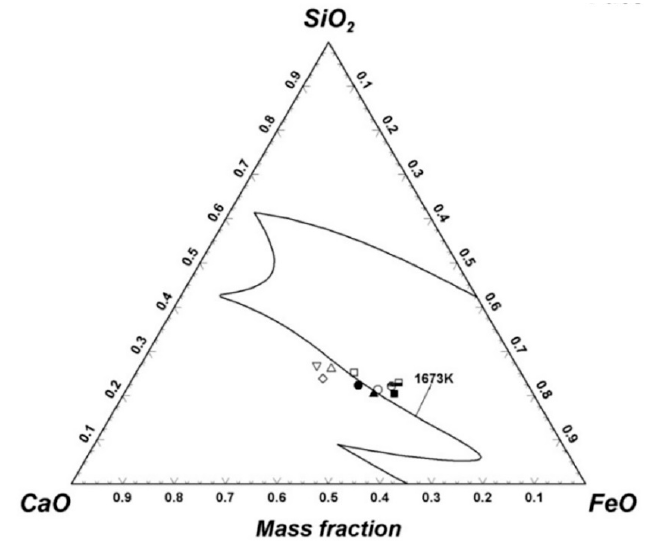
Figure 5. Position of liquid slag phase components in different slag samples in the phase diagram of the CaO-SiO 2 -FeO ternary system.